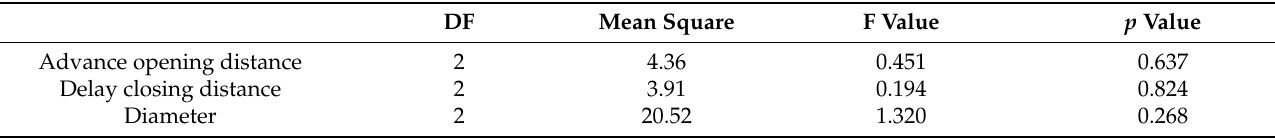
Table 5. Results of significance